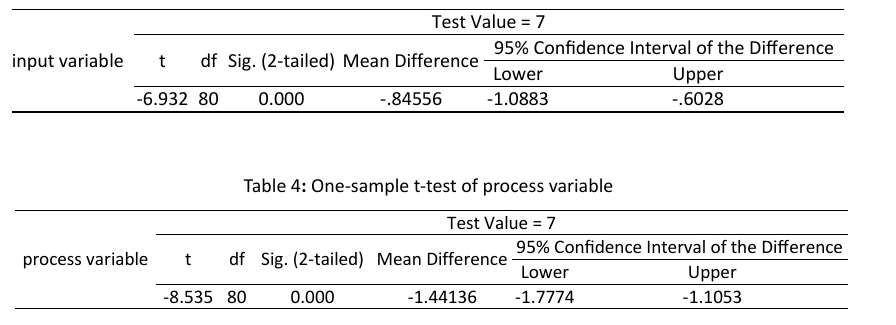
Table 3: One-sample t-test of input variable